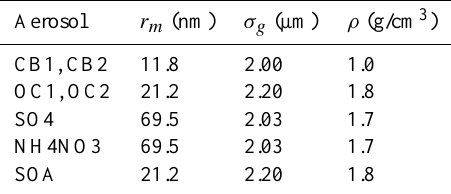
Table 6. Bulk aerosol parameters used in calculation of surface area: number distribution mean radius ( r m ), geometric standard de- viation ( σ g ) and density.